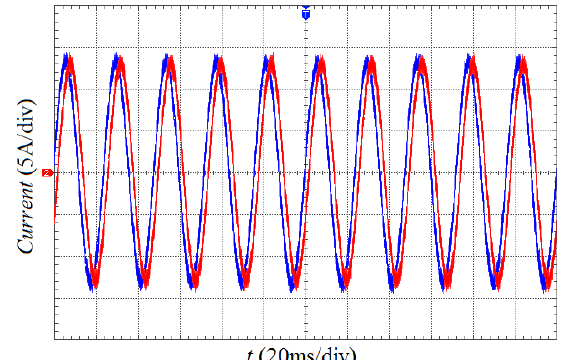
Figure 25. Experimental result of DZICMV at m = 0.9703: ( top ) line voltage u ab ( bottom ) the FFT analysis of u ab .